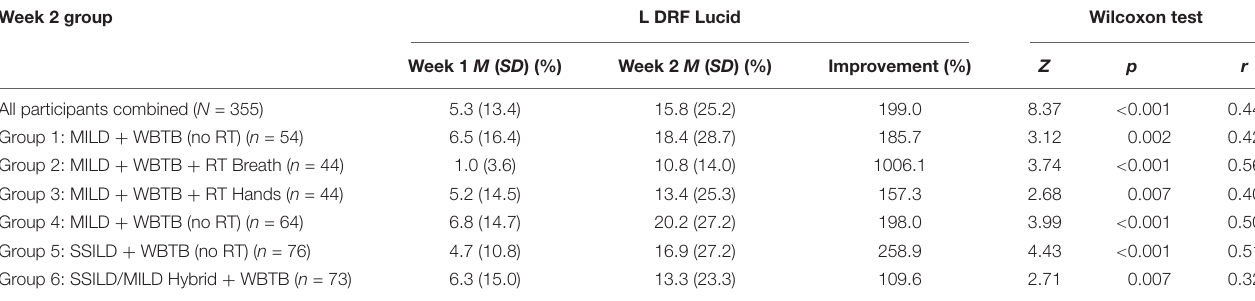
TABLE 4 | Differences between week 1 and Week 2 lucid dreaming rates for all participants combined and for each of the six week 2 groups. Week 2 group L DRF Lucid Wilcoxon test